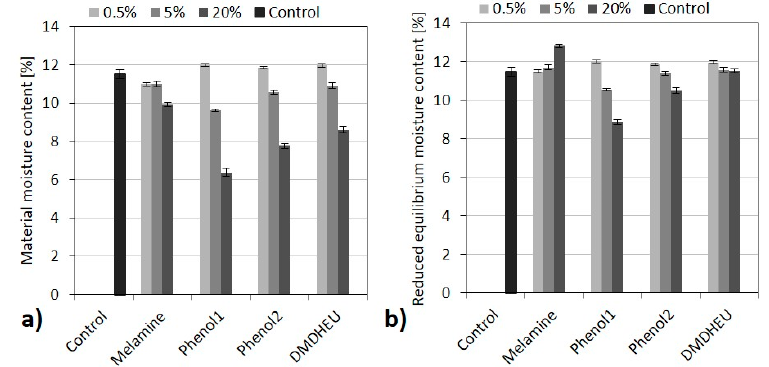
Figure 1. (a) Material moisture content MC (%) and (b) reduced equilibrium moisture content EMC R (%) at 20 °C and 65% RH of impact bending specimens depending on the modification agent (mean and SD).